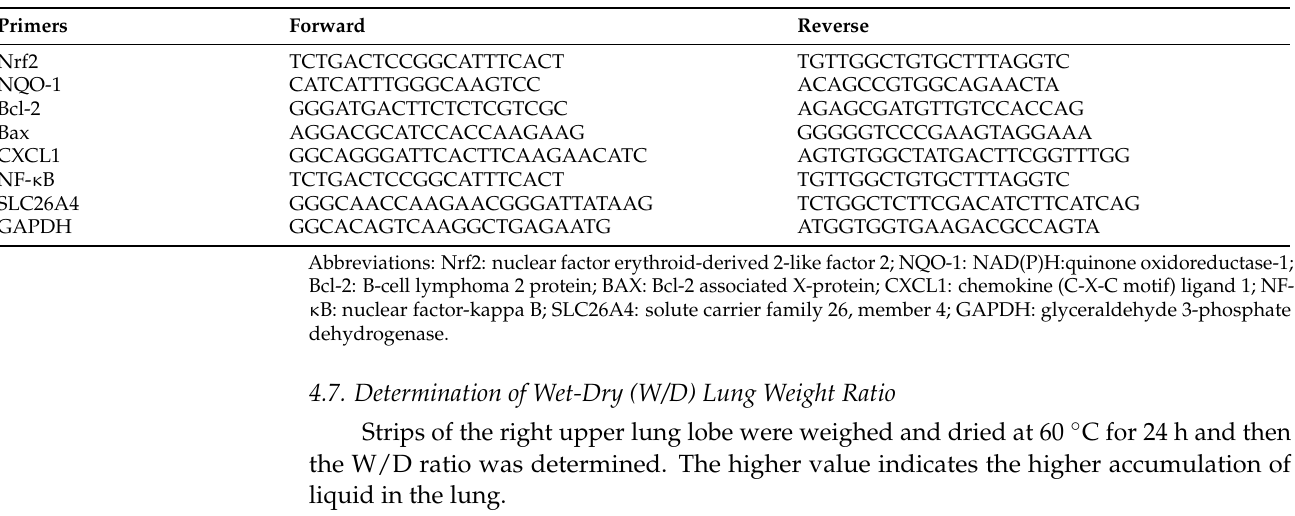
Table 4. The primer sequences amplified used for